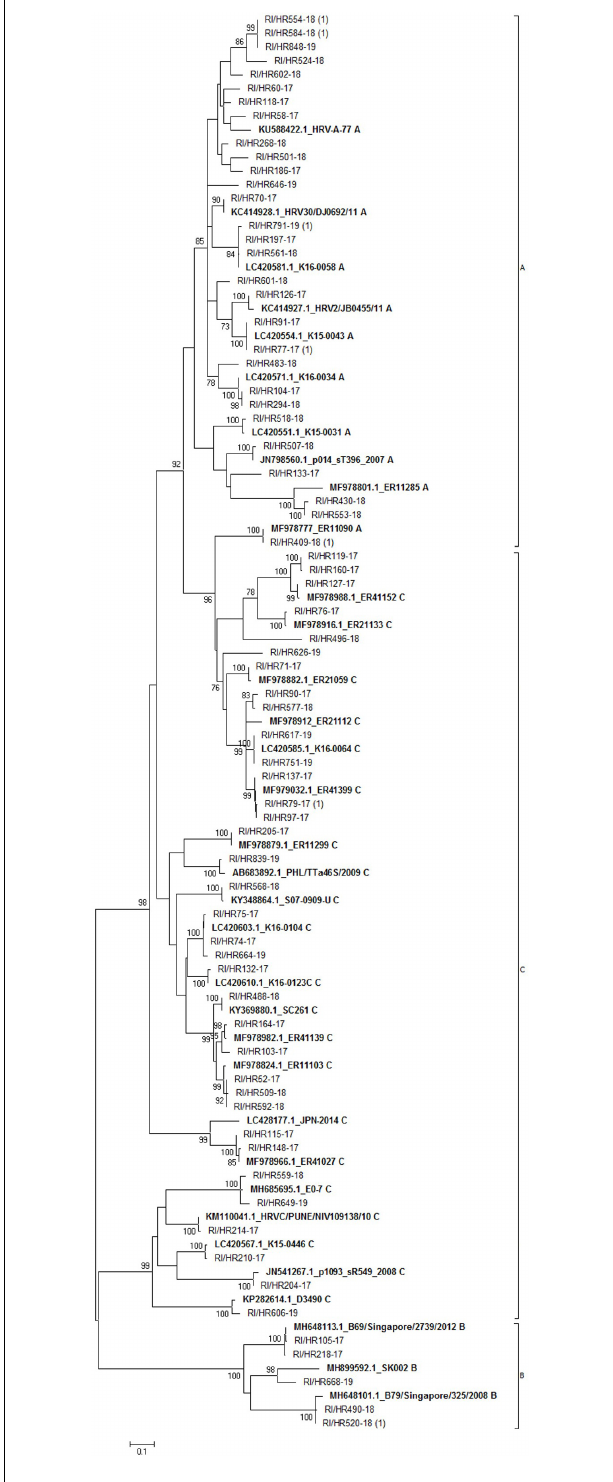
FIGURE 3 | Phylogenetic tree of rhinovirus strains. The tree includes 69 sequences obtained in this study and 34 sequences retrieved from the GenBank. Tree was generated using the maximum-likelihood method; a Hasegawa-Kishono-Yano model with gamma distribution rate and